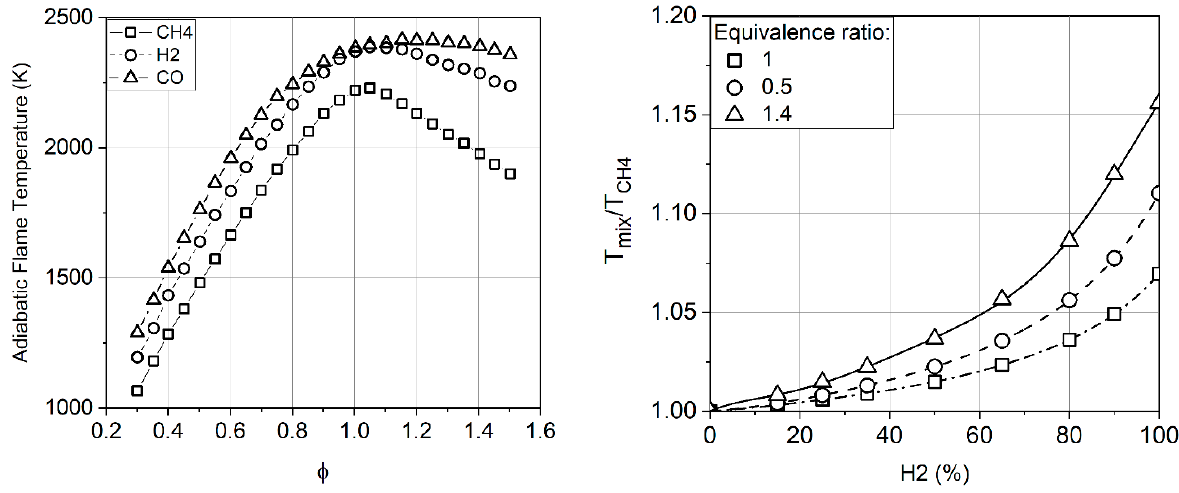
Figure 2. Influence of hydrogen volume concentration on the normalized temperature of the methane–air mixture flame [3,8,9].